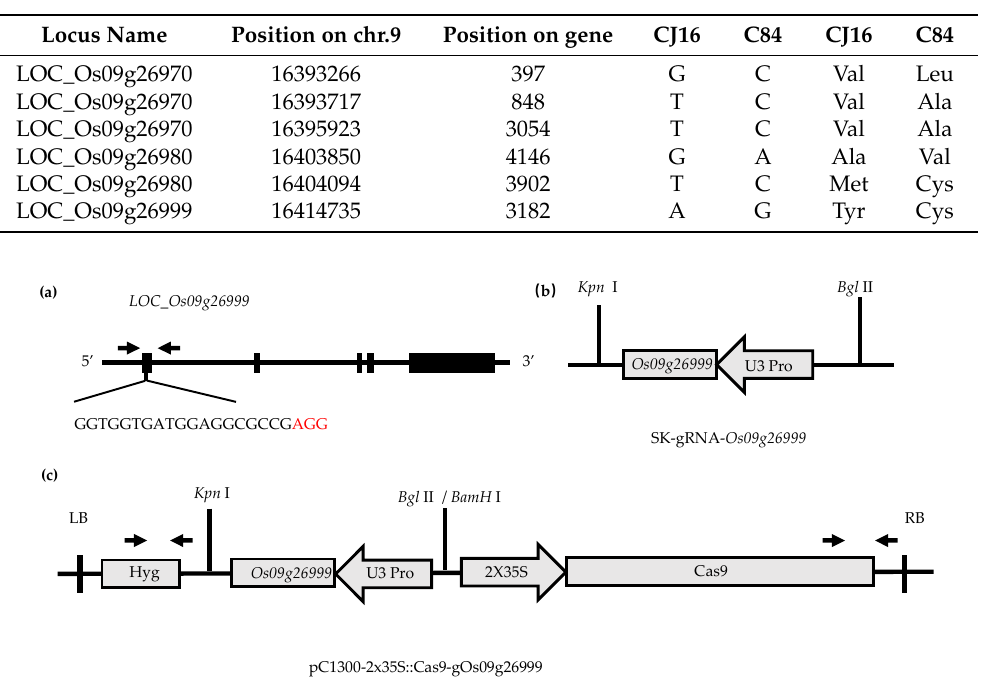
Table 5. The position of SNP and amino acid variation for the three candidate genes.